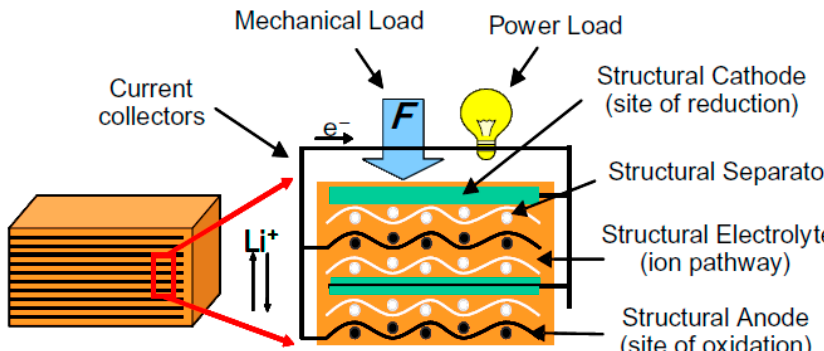
Figure 6. Structural battery scheme.